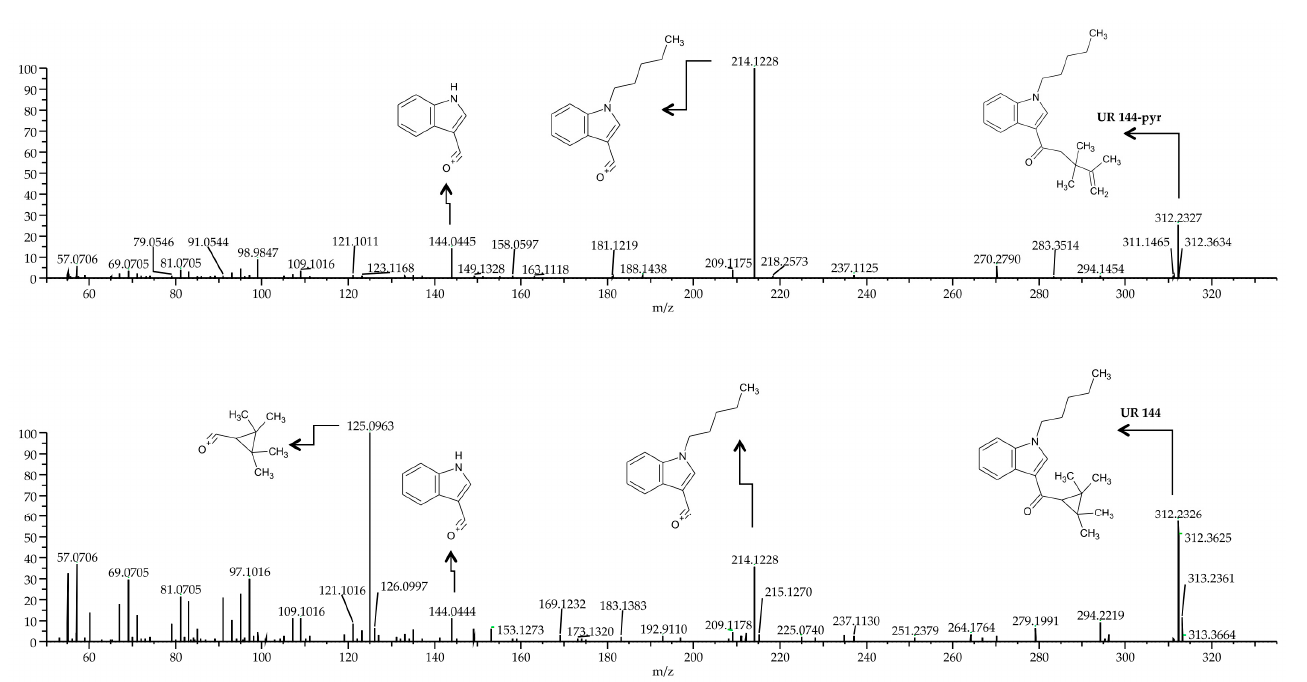
Figure 4. Full mass spectra of UR-144-pyr and UR-144 .